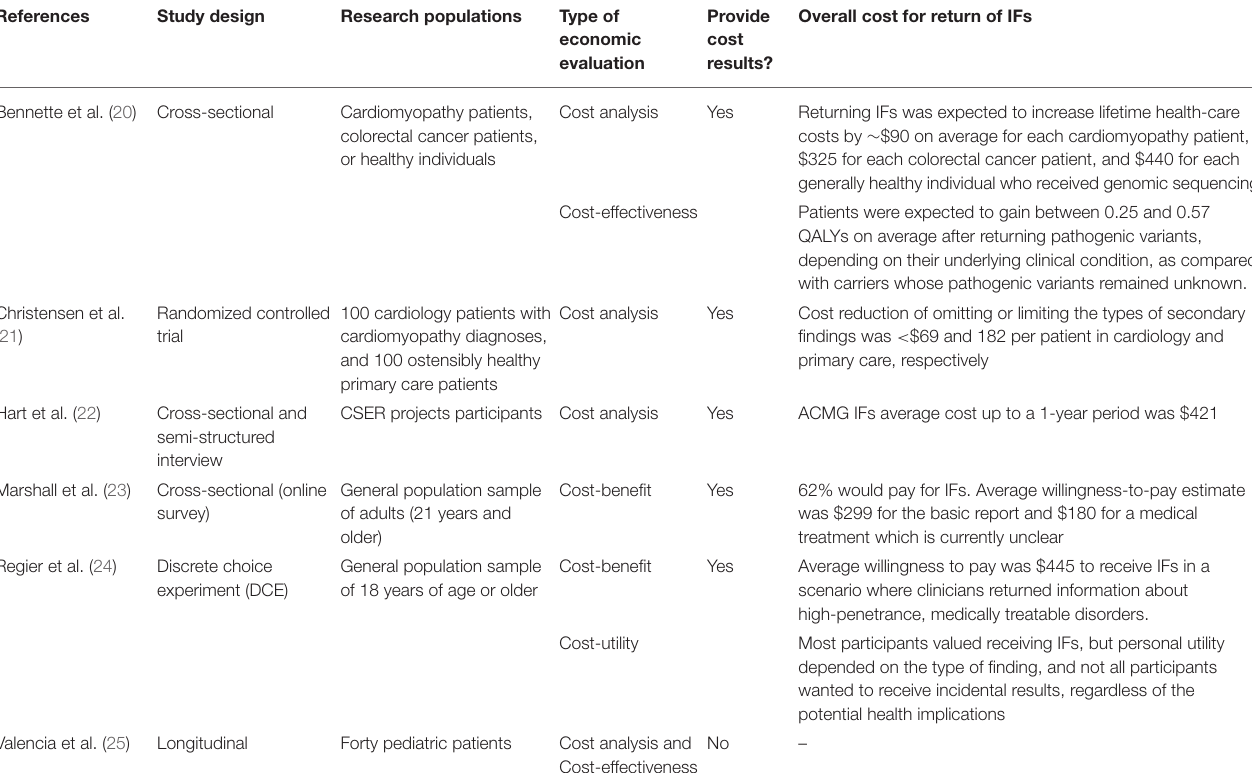
TABLE 1 | Characteristics of studies that met inclusion